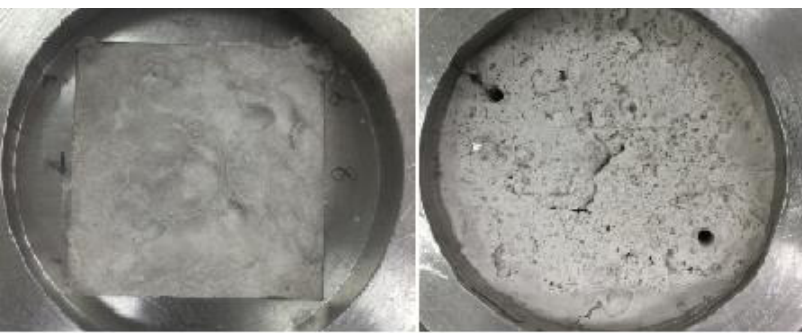
Figure 10. Sediment morphology before and after hydrate dissociation for run 2.